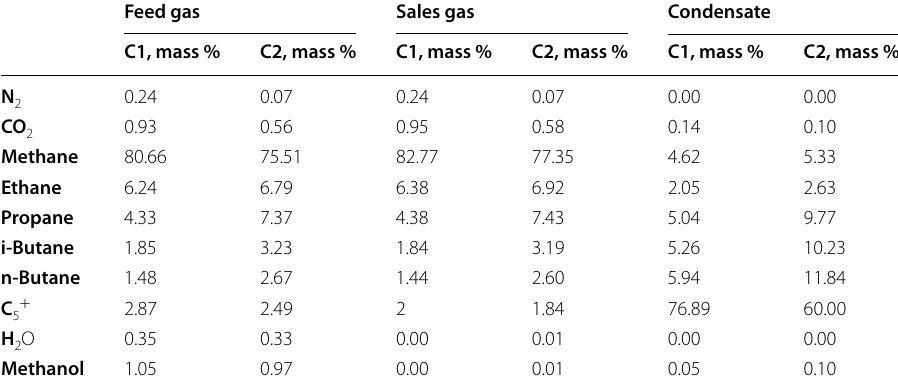
Table 4 Mass balance of low temperature separation train streams Feed gas Sales gas Condensate C1, mass %